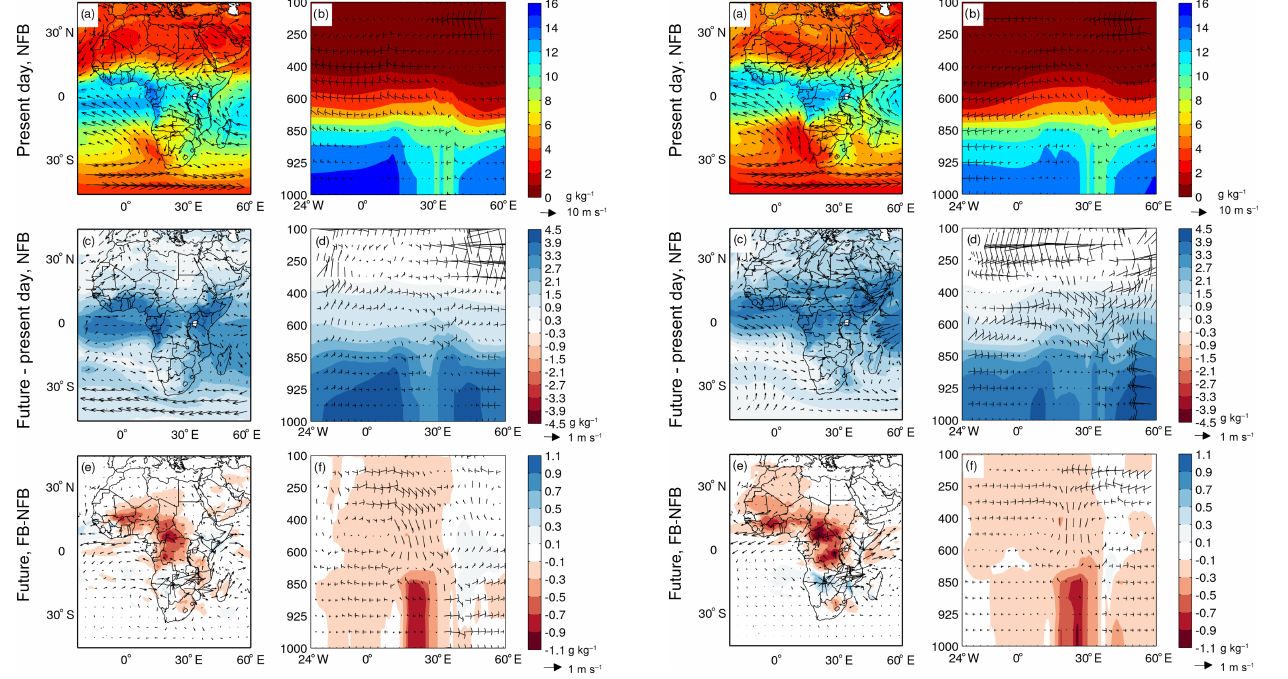
Figure 8. Atmospheric circulation (arrows, ms − 1 ) and specific humidity (colour contours, gkg − 1 ) at 850hPa pressure level for MAM, displayed as (a, c, e) for the entire domain, and (b, d, f) as a cross section for a latitude band between 2.5 ◦ S and 2.5 ◦ N, for present day (top), climate change impacts (middle) and the vegeta- tion feedback (bottom). Definitions for calculation period, climate change signal and vegetation feedbacks are given in Sect. 2.2.